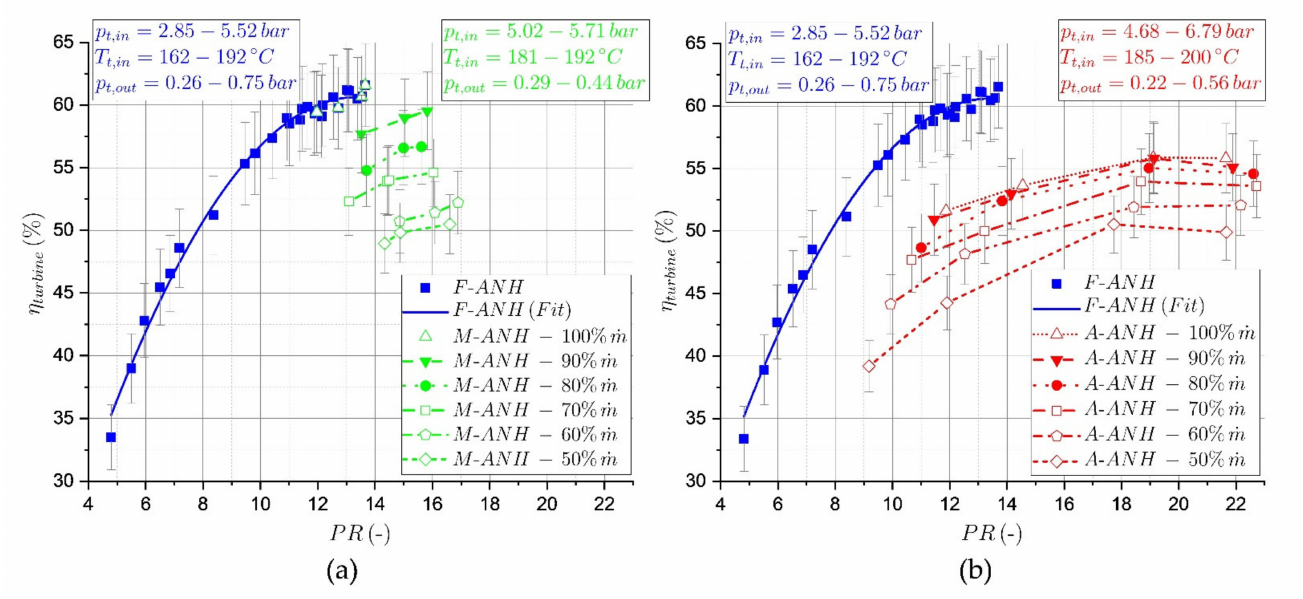
Figure 9. Total-to-static isentropic turbine efficiency for F-ANH and M-ANH ( a ) and for F-ANH and A-ANH ( b ) as a function of the pressure ratio ( PR